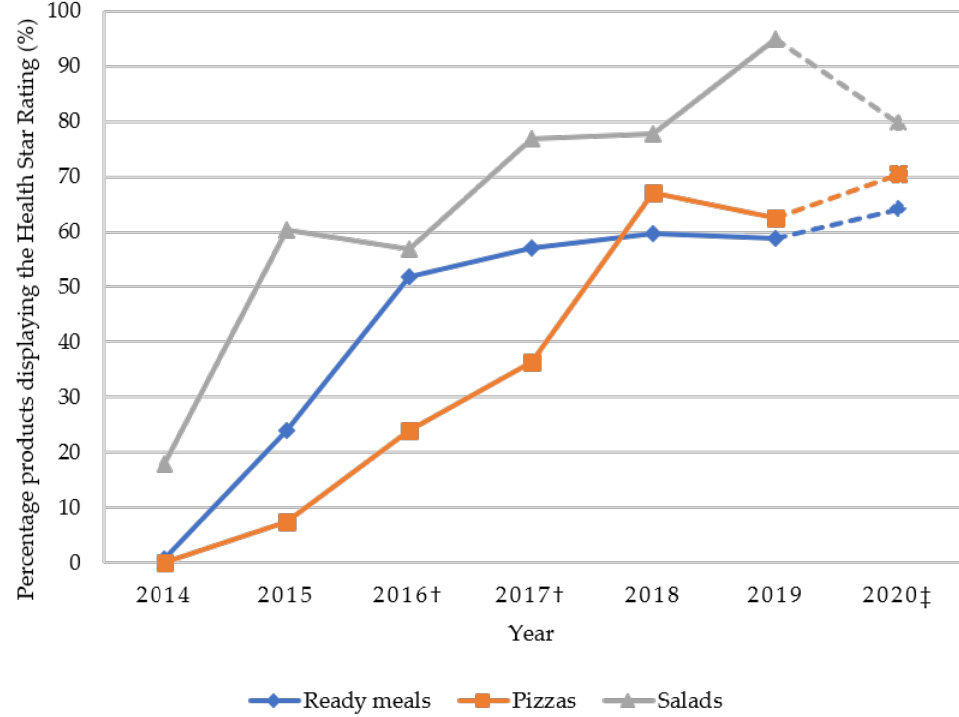
Figure 2. Percentage of ready meals, pizzas and salads displaying the Health Star Rating from 2014 to 2020. Data for 2014 to 2019 from FoodTrack™ database; † ALDI products introduced in 2016 and IGA products introduced in 2017; ‡ data for 2020 from Woolworths, Coles and ALDI in Adelaide. Table 1. Serving size and price of ready meals, pizzas and salads from 2014 to 2020 (median). Year Data Were Collected Type of p -Value Product Type of Product